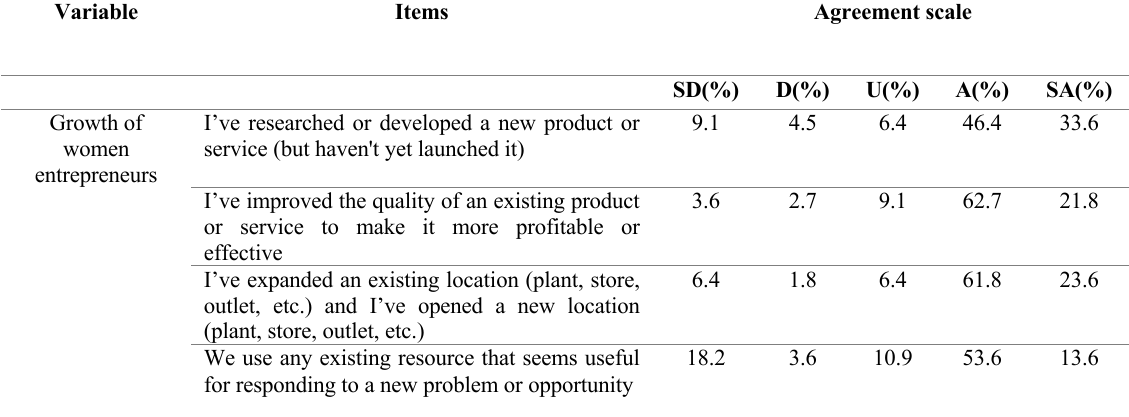
Table 5: Responses on Growth of women